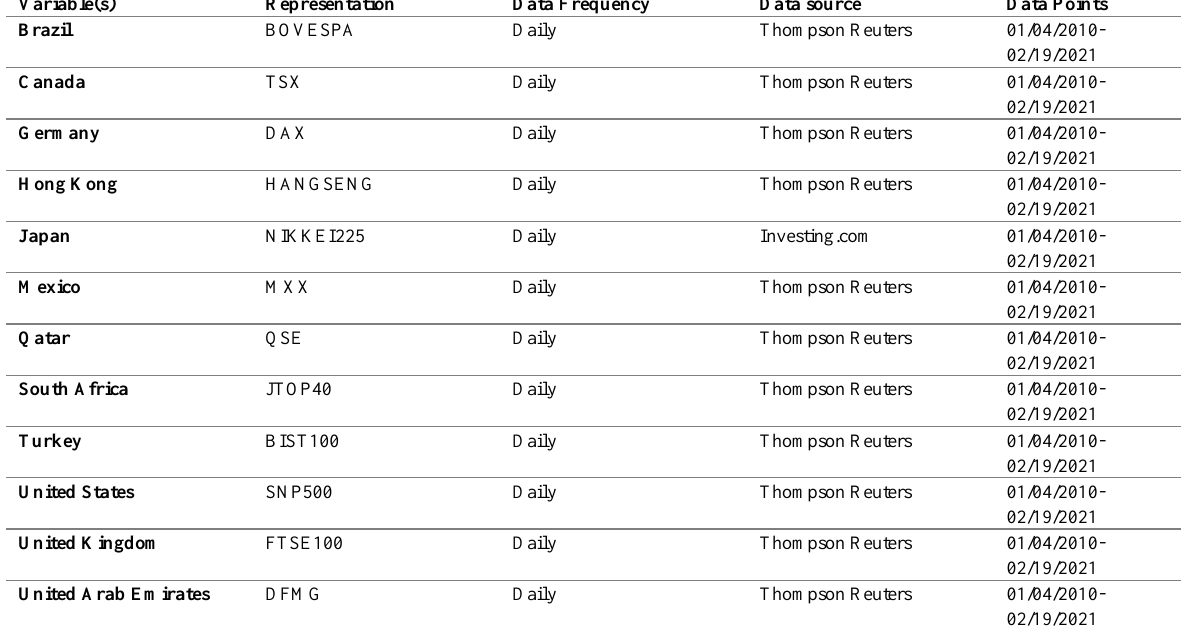
Table 1: Representation of Variables and Data